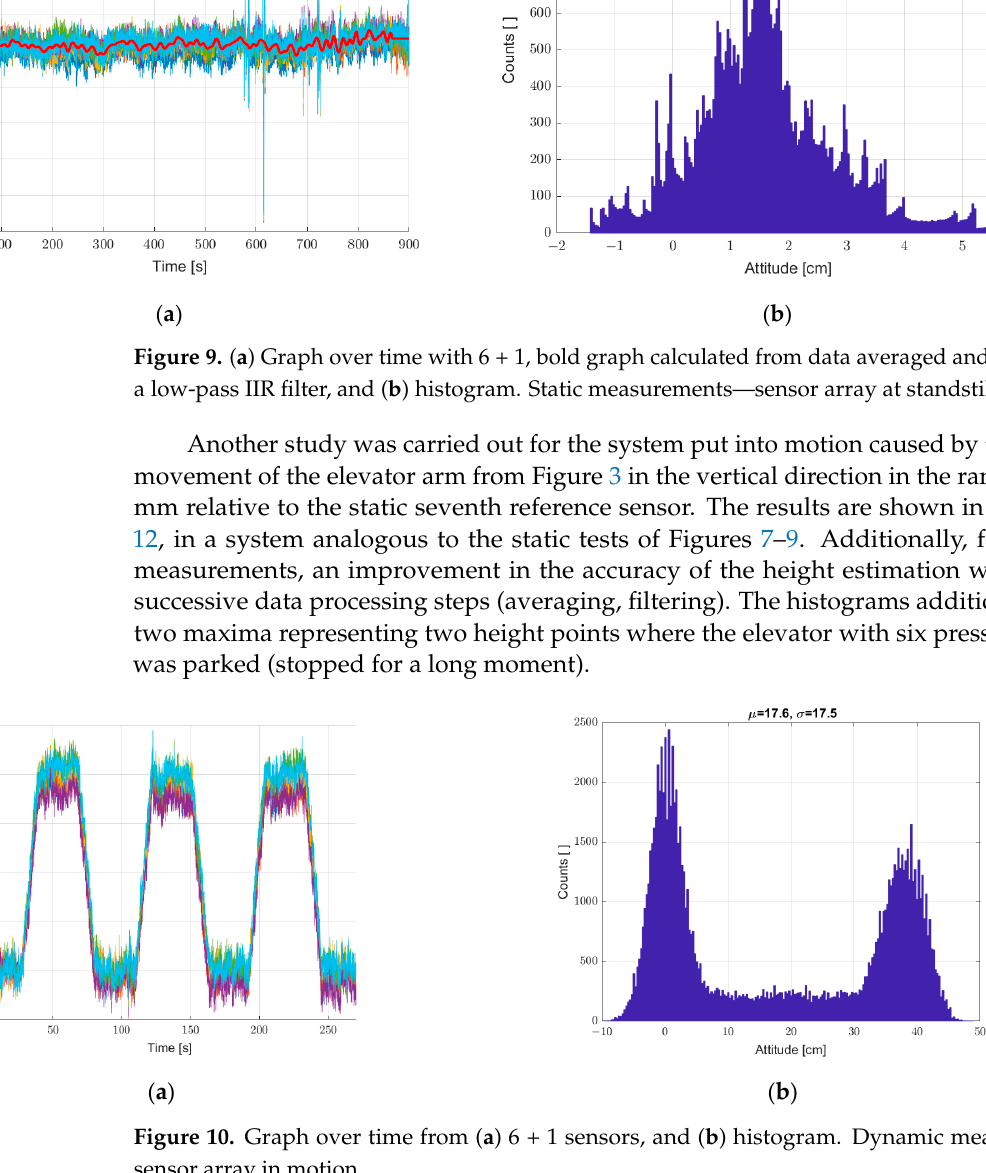
( b ) Figure 11. ( a ) Graph over time from 6 + 1 sensors, a bold graph calculated from the average of indi- vidual sensors, and ( b ) histogram. Dynamic measurements—sensor array in motion.